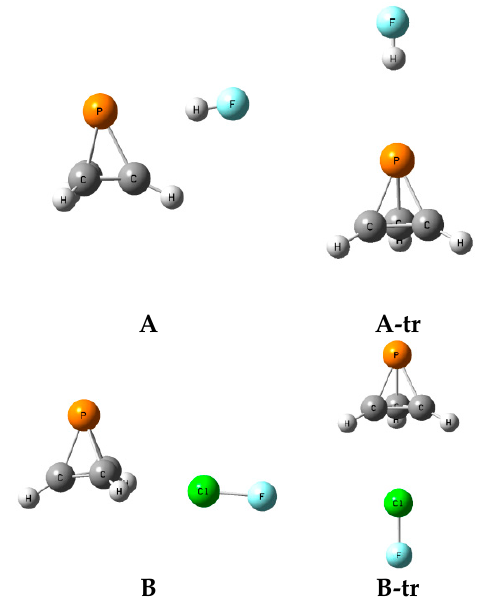
Figure 8. Complexes FH:P(CH) 3 ( A ) and ( A-tr ), and ClF:P(CH) 3 ( B ) and ( B-tr ). Table 7. Binding energies ( − ∆ E), barriers ( ∆ E † , kJ mol − 1 ), and intermolecular distances (R,Å), for